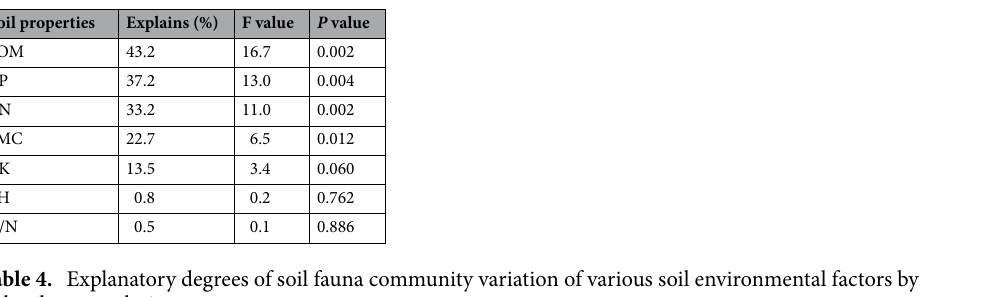
Table 4. Explanatory degrees of soil fauna community variation of various soil environmental factors by redundancy analysis.